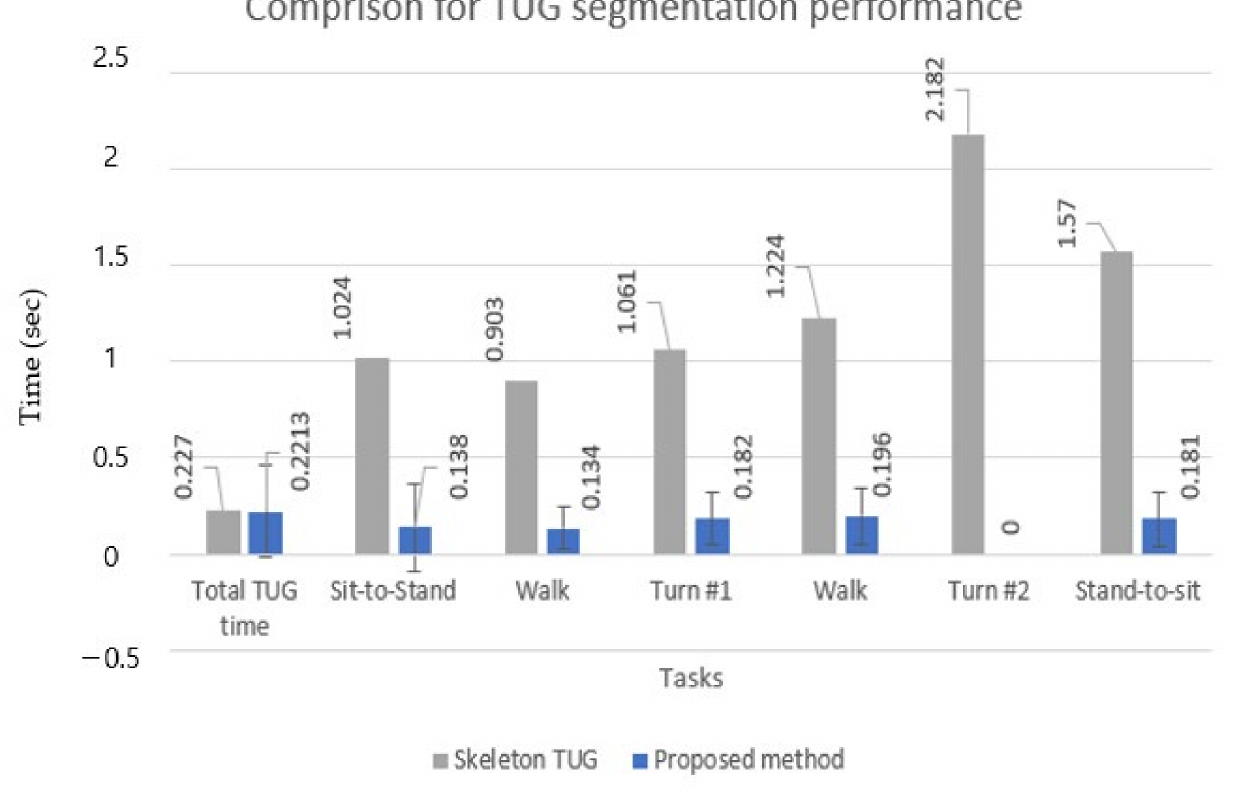
Figure 10. Comparison of MAE and STD for total TUG time and subtask